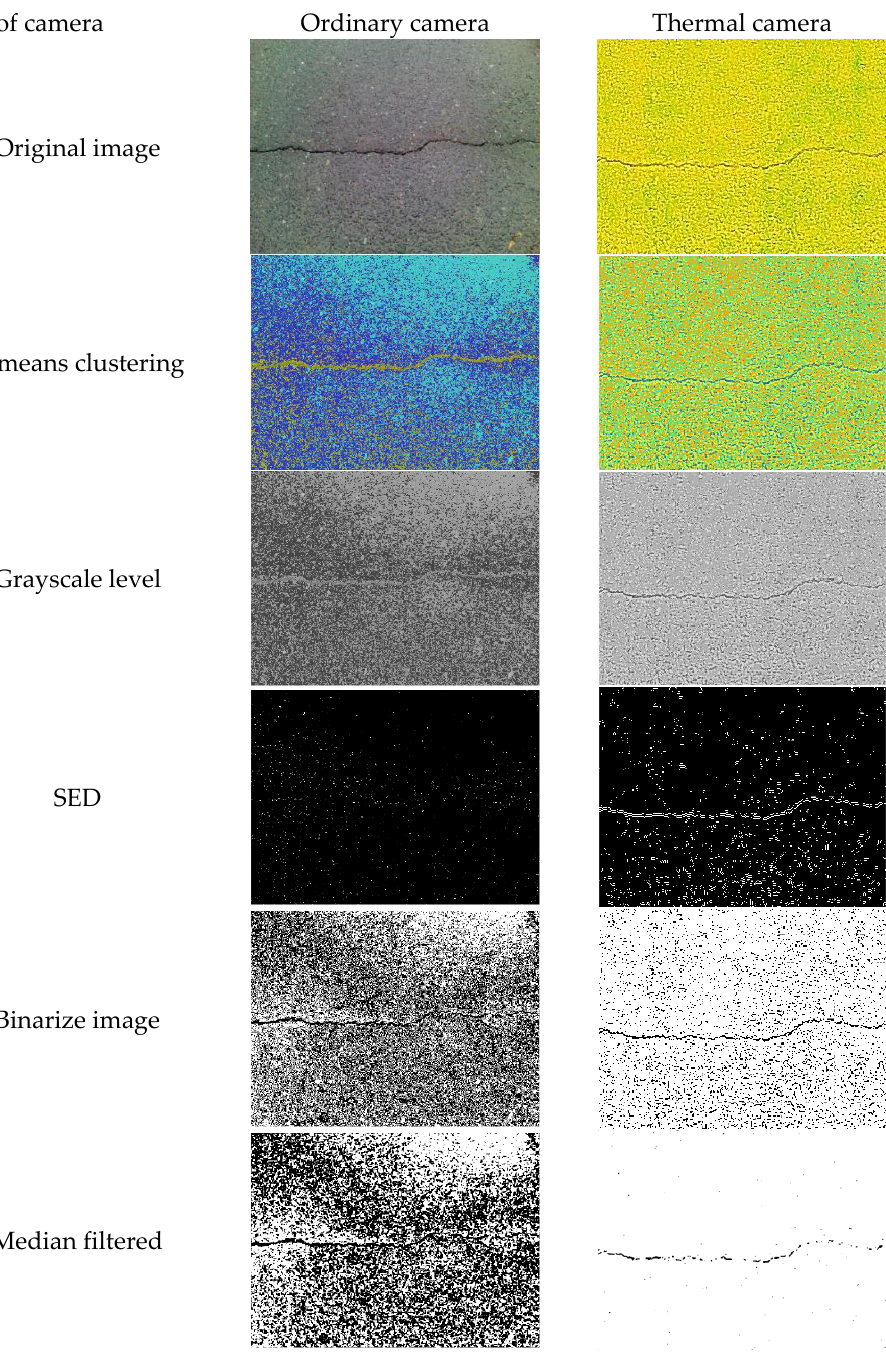
Figure 12. Sample results of the proposed image processing.